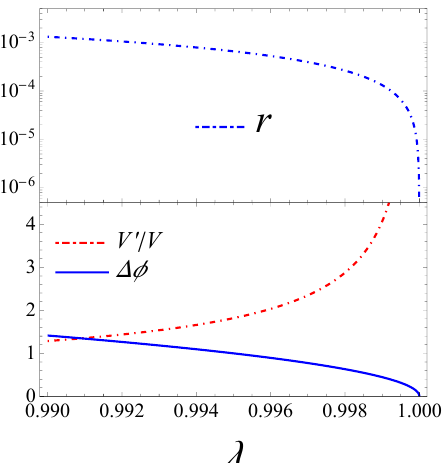
Figure 1. The dependence on λ for the power-law potential with p = 2. The upper panel shows the tensor-to-scalar r . The lower panel shows the gradient of the potential V (cid:48) / V and the field excursion ∆ φ